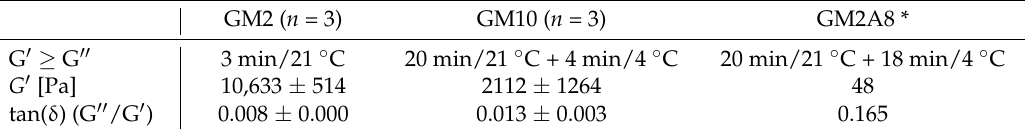
Table 2. Rheological analysis of GM(A) solutions (10% ( w / w )) during cooling (20 min 21 ◦ C + 40 min 4 ◦ C). Gelation was determined when the storage modulus G (cid:48) became larger than the loss modulus G (cid:48)(cid:48) ( G (cid:48) ≥ G (cid:48)(cid:48) ). Furthermore, the storage moduli of the physical hydrogels measured at the end of